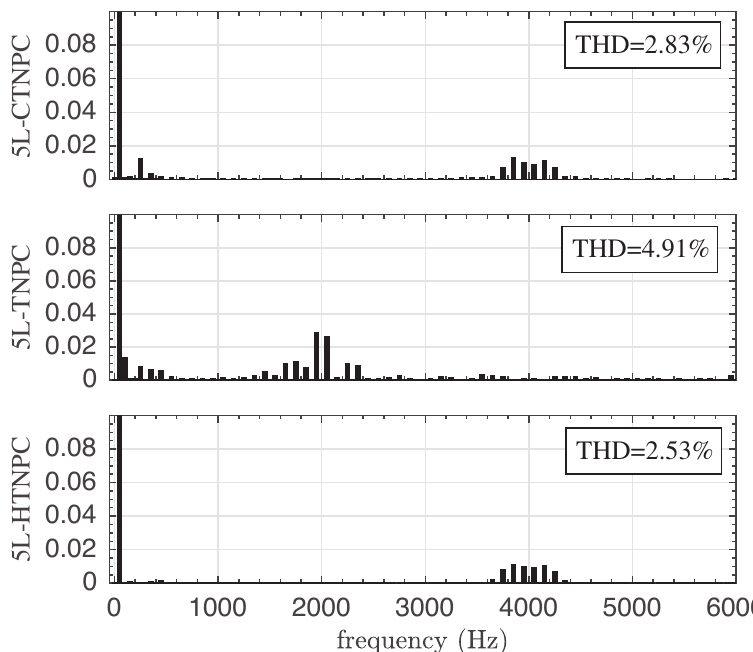
Figure 18. Grid current FFT comparison between 5L-CTNPC, 5L-HTNPC and 5L-TNPC inverter